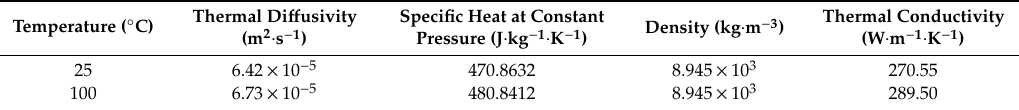
Table 2. Thermophysical parameters of